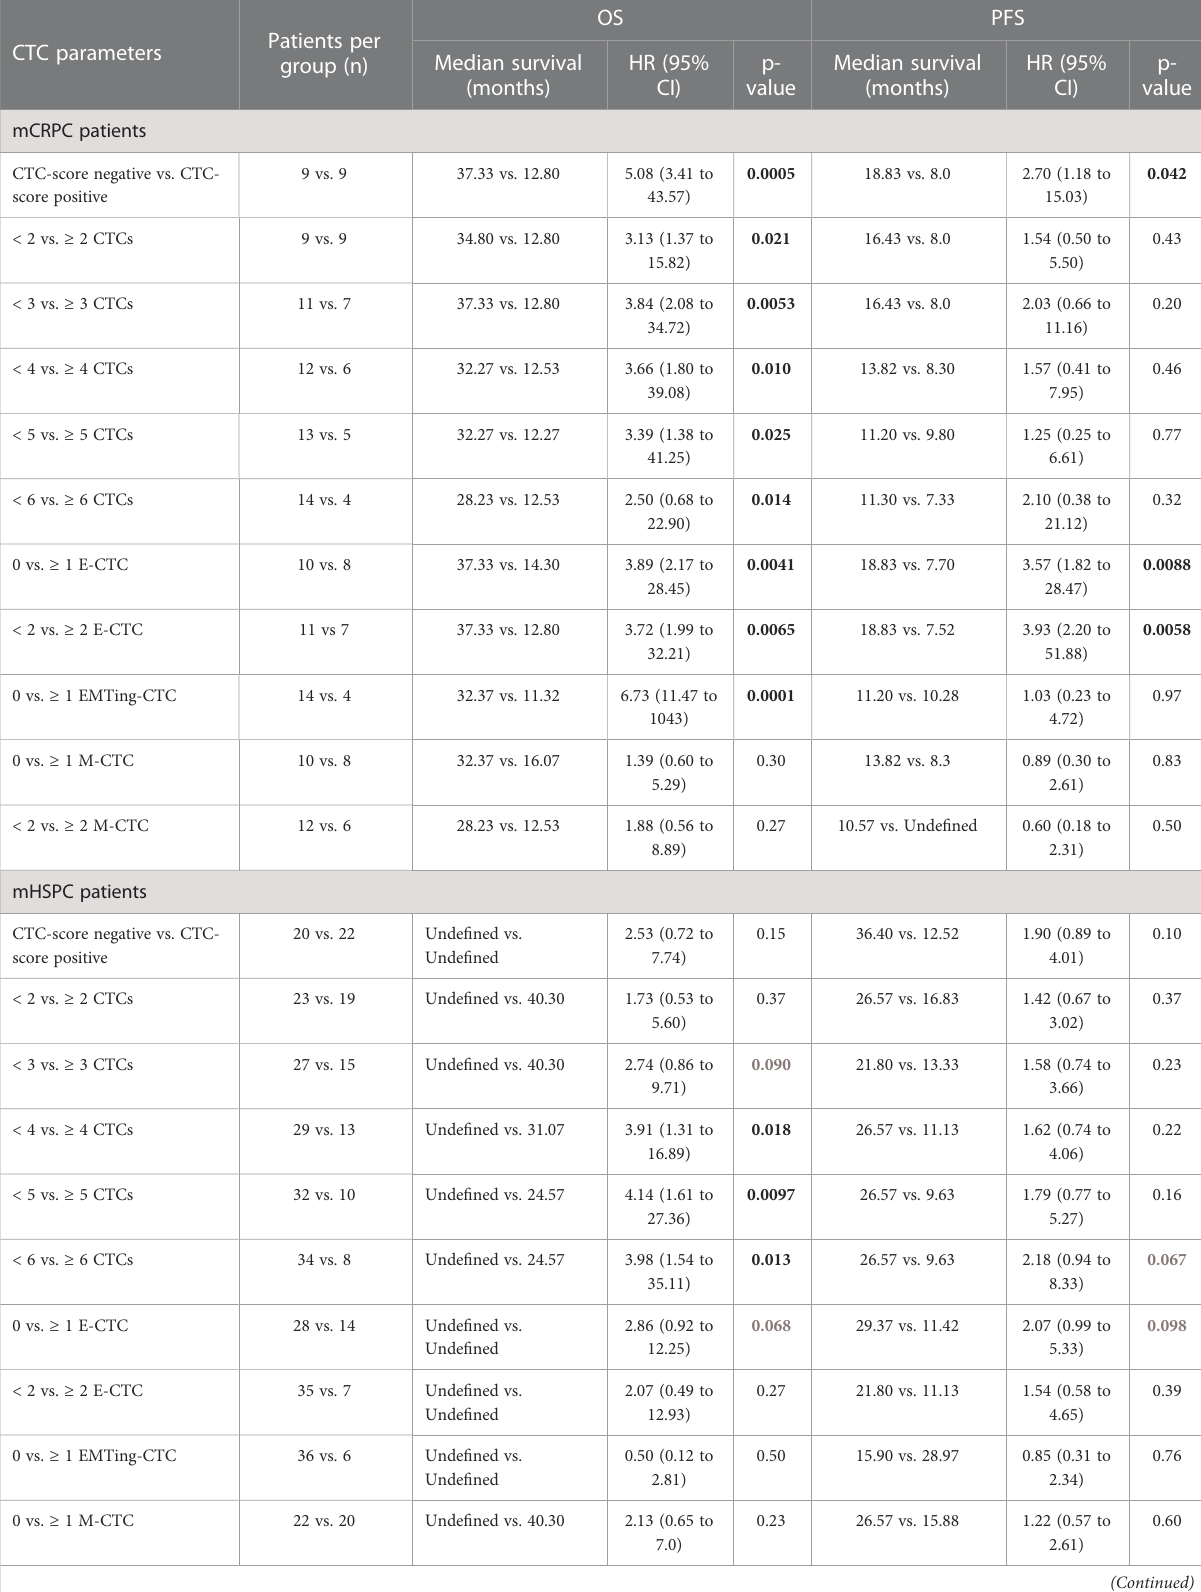
TABLE 4 Kaplan Meier analysis of CTC enumeration cut-offs for OS and PFS in mCRPC and